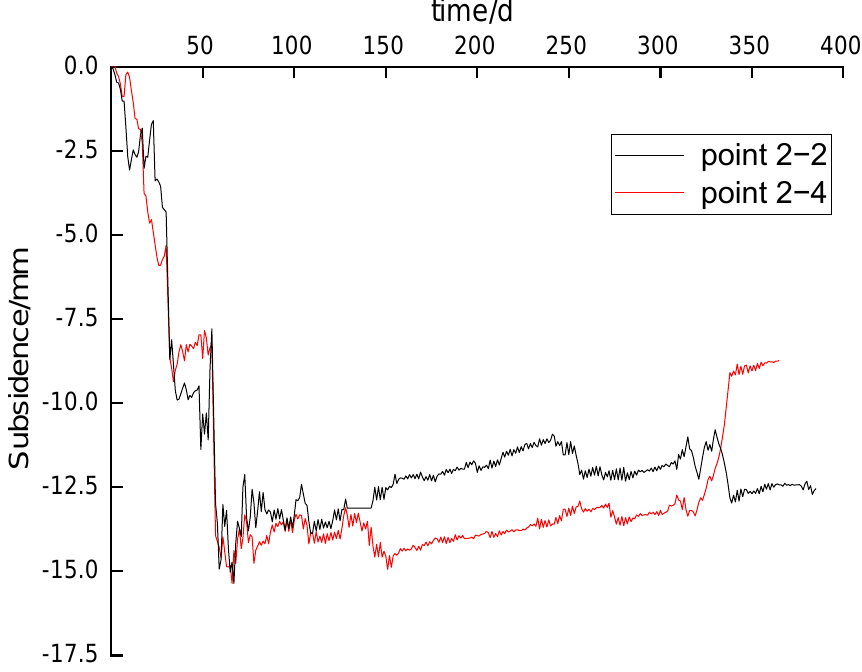
Figure 4. Measured curves of surface settlement at points 2 − 2 and 2 − 4.